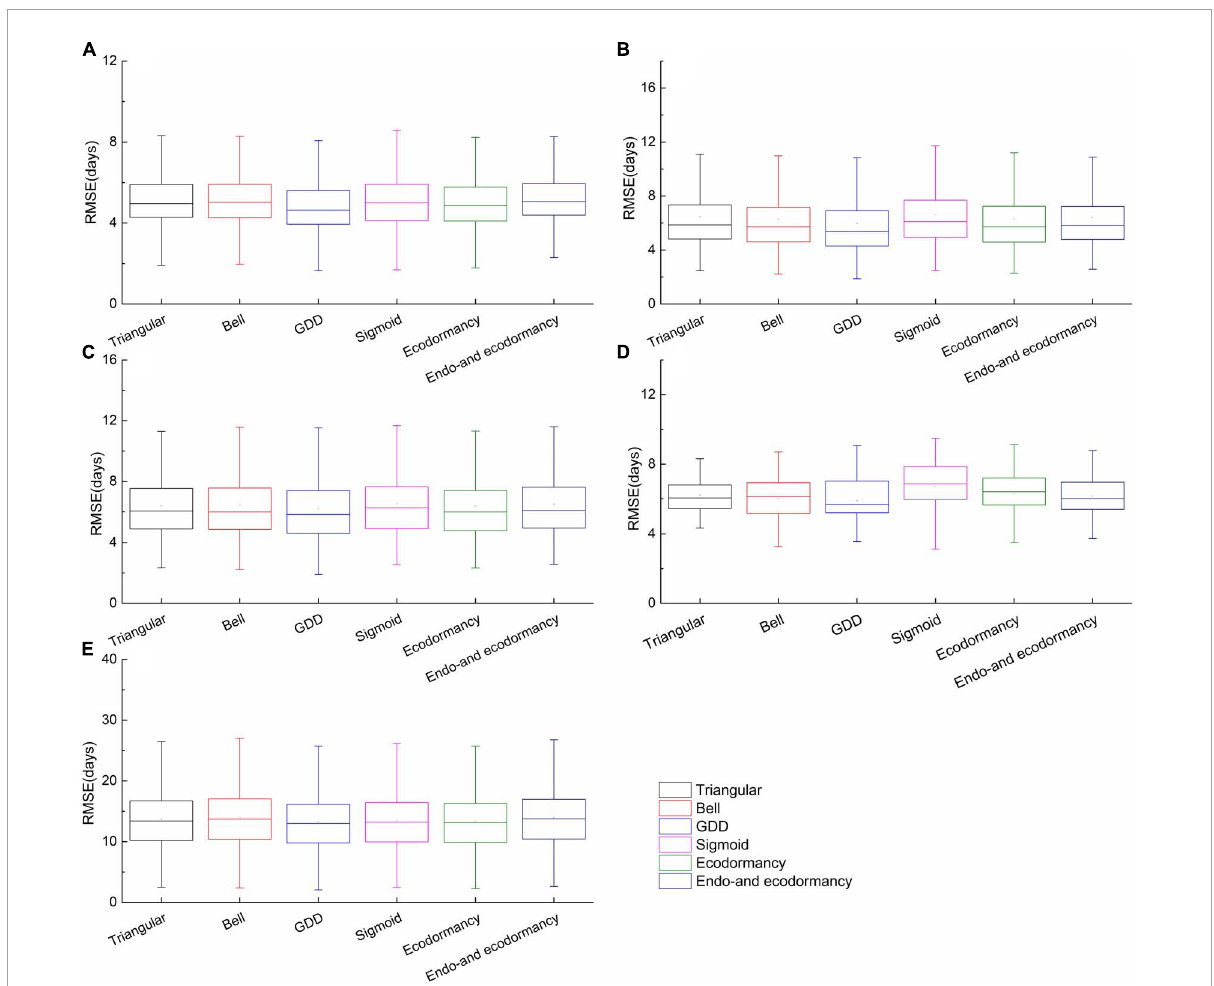
FIGURE4 RMSE predicted by spring phenological models with different temperature response functions and model structures: (A) deciduous needleleaf forest (DNF), (B) mixed forest (MF), (C) open shrublands (OSL), (D) woody savannas (WS), and (E) grasslands (GL). Triangular and Bell are the average results of the model using triangular temperature response (SQ, PA, SM1, and PM1) and bell-shape temperature response (SQb, PAb, SM1b, and PM1b) during the endodormancy phase, respectively. GDD and Sigmoid are the average results of the model using growing-degree-day temperature response (TT, PTT, and M1) and sigmoid temperature response (TTs, PTTs, and M1s) during the ecodormancy phase, respectively. Ecodormancy, and endo- and ecodormancy, refer to the average results of the one-phase model and the two-phase model,